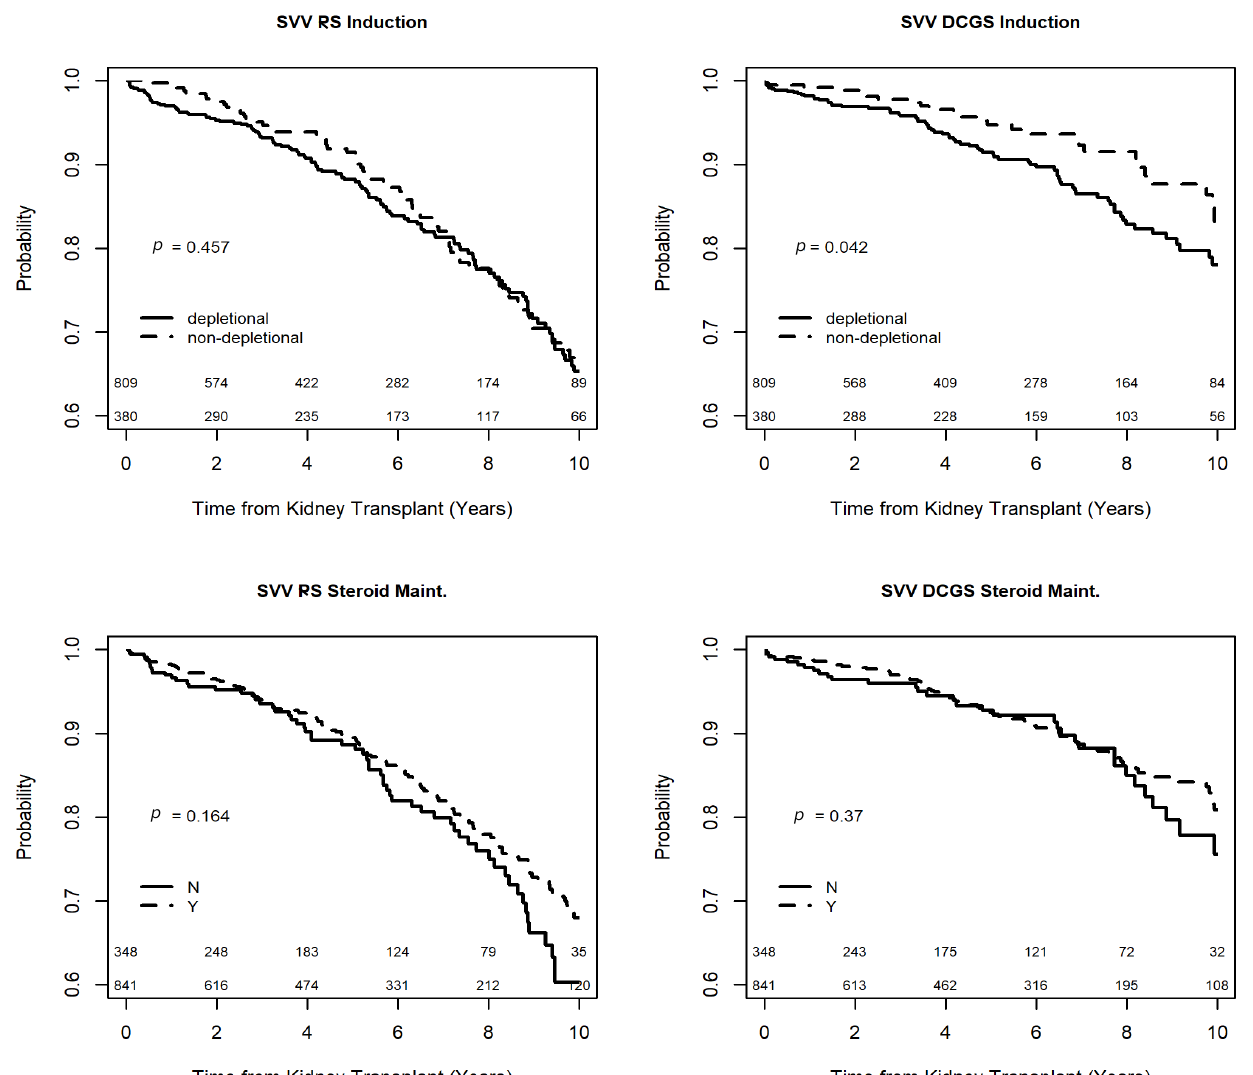
Figure 7. Univariable Kaplan–Meier Estimates of Recipient Survival (RS) and Death-Censored Graft Survival (DCGS) by Induction Type and Steroid Maintenance in SVV.